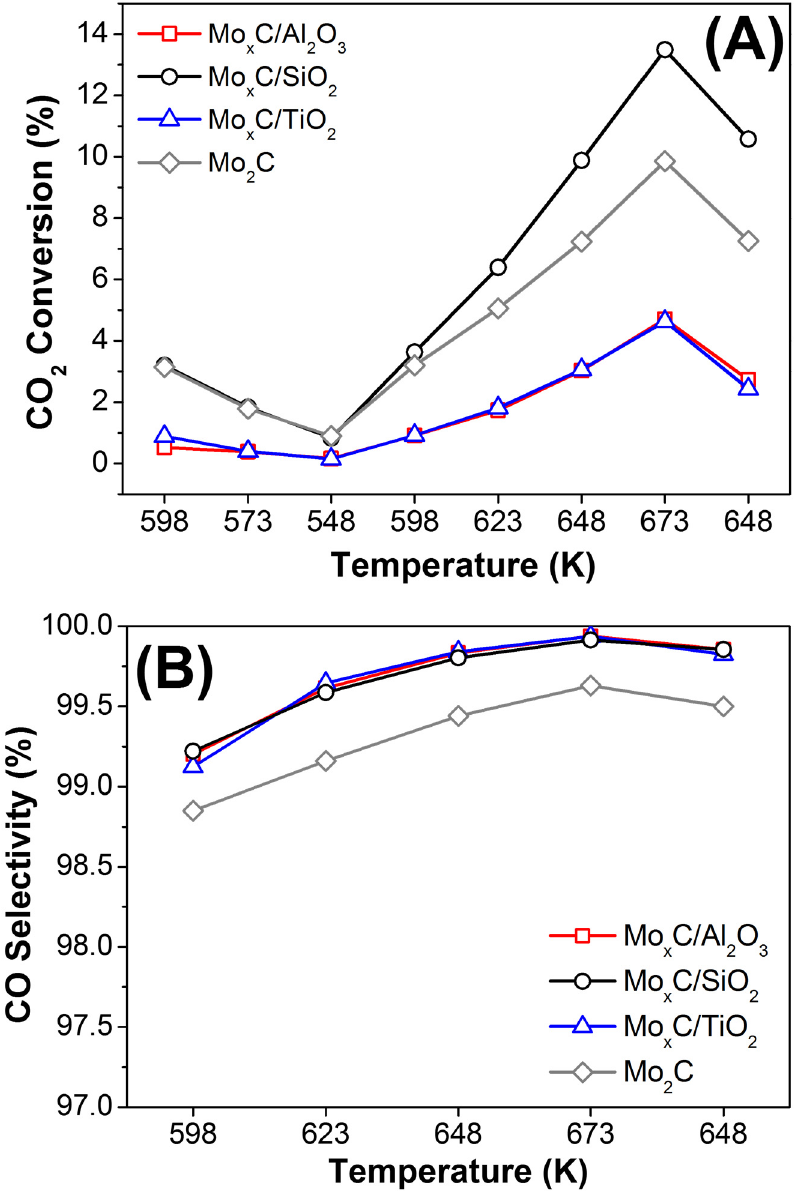
Figure 10. Catalytic behavior of Mo x C/support and unsupported reference Mo 2 C catalysts in the RWGS reaction as a function of reaction temperature; ( A ) CO 2 conversion, ( B ) CO selectivity. Reaction conditions: m cat = 150 mg, CO 2 /H 2 /N 2 = 1/1/3, GHSV = 3000 h − 1 , P = 0.1 MPa.